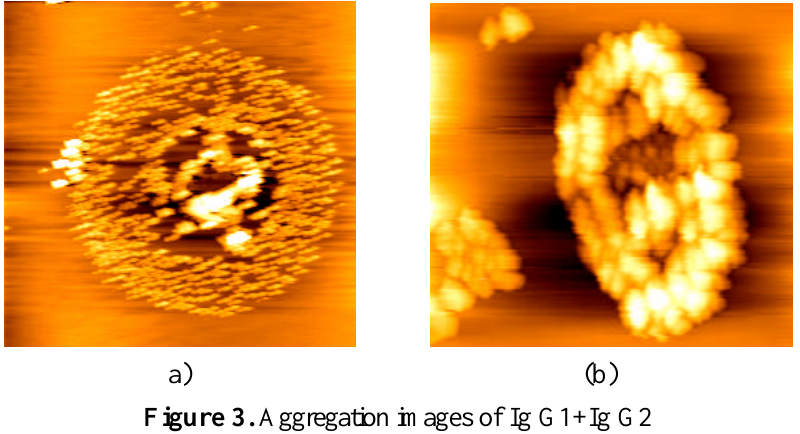
Figure 3. Aggregation images of Ig G1+Ig G2 Scanning scope: a. 7µm; b. 1µm.